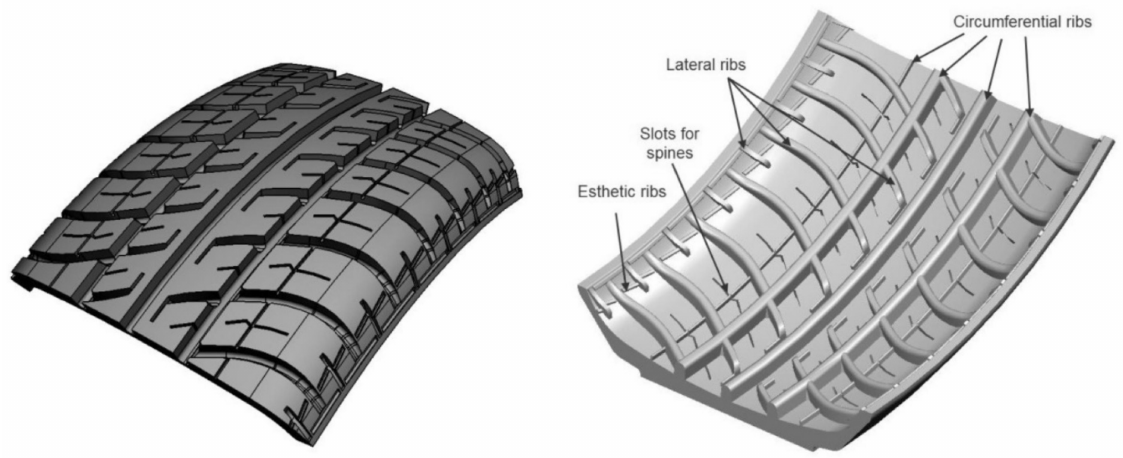
Figure 27. Tyre tread segment and tread ring vulcanisation mould segment